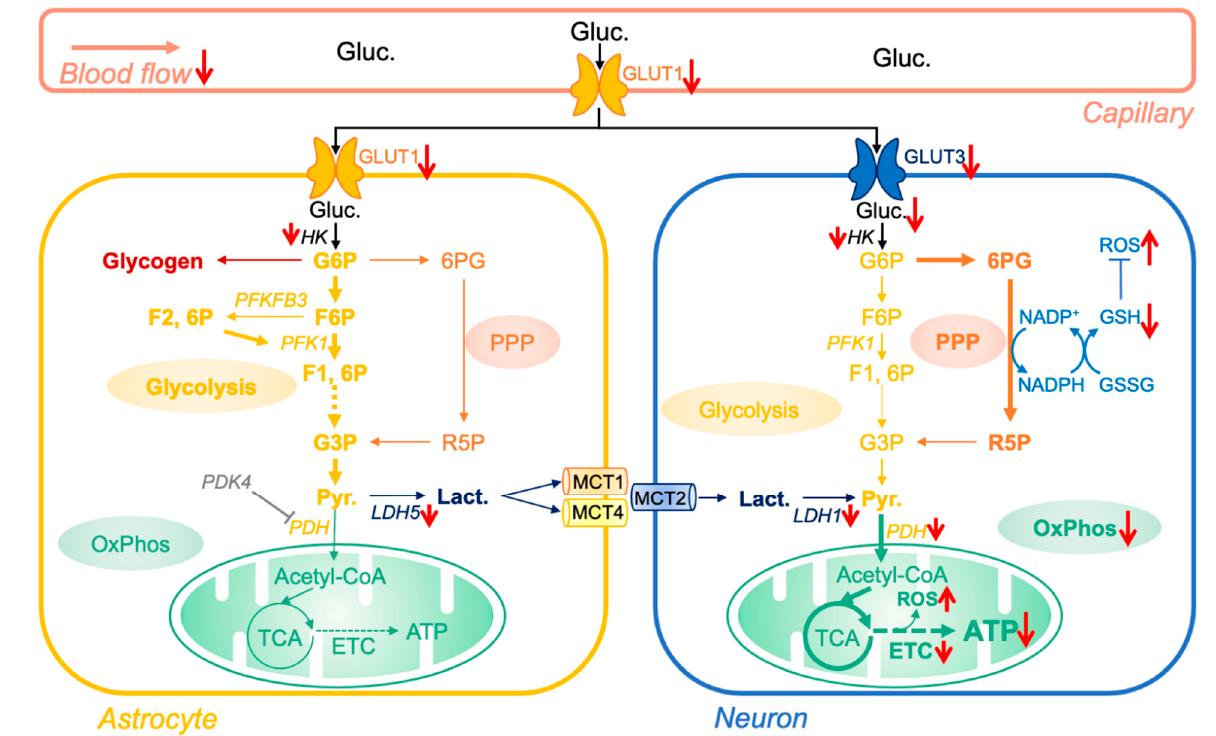
Figure 1. Impact of aging on brain glucose metabolism. Glucose (Gluc.), derived from nutritional sources, is transported to the brain through the blood flow. After entering astrocytes via glucose transporter 1 (GLUT1), glucose is either metabolized via the glycolytic pathway to form pyruvate (Pyr.) or stored as glycogen. Pyruvate is then converted into lactate by the lactate dehydrogenase 5 (LDH5) and, according to the astrocyte-neuron lactate shuttle hypothesis, transported to neurons via the monocarboxylic acid transporters 1, 2, and 4 (MCT1 and 4 at the astrocyte membrane, MCT2 at the neuron membrane). Due to the pyruvate dehydrogenase kinase 4 (PDK4)-dependent inhibition of pyruvate dehydrogenase (PDH), astrocytes have only limited oxidative phosphorylation (OxPhos) activity and rely on glycolysis for ATP production. Lactate entering in neurons is converted to pyruvate via the lactate dehydrogenase 1 (LDH1) and enters in the tricyclic acid cycle (TCA), generating substrates for OxPhos and ATP production. Glucose can also enter neurons via the glucose transporter 3 (GLUT3). However, due to the constant proteasome degradation of the 6-phosphofructo-2-kinase/fructose 2,6-biphosphatase, isoform 3 (PFKFB3), neurons have low glycolytic capacity. Therefore, glucose is mainly metabolized via the pentose phosphate pathway (PPP) to generate reduced nicotinamide adenine dinucleotide phosphate (NADPH). NADPH is then used to produce oxidized antioxidants such as glutathione, which are paramount to regulate the reduction/oxidation state in neurons. Of note, reactive oxygen species (ROS) are by-products of OxPhos activity, which are neutralized by antioxidant defenses (e.g., GSH/GSSG system). The red arrows indicate proteins and molecules that are impacted ( ↑ increased/ ↓ decreased) in brain aging. Abbreviations: 6PG, 6-phos-phogluconate; ETC, electron transport chain; F6P, fructose-6-phosphate; F1, 6P, fructose-1,6-diphosphate; F2, 6P, fructose-2,6-diphosphate; G3P, glyceraldehyde-3-phosphate; GSH/GSSG, reduced/oxidized glutathione; HK, hexokinaseG6P, glucose-6-phosphate; G3P, glucose-3-phosphate; PKF1, phosphofructokinase 1; R5P, ribulose-5-phosphate.